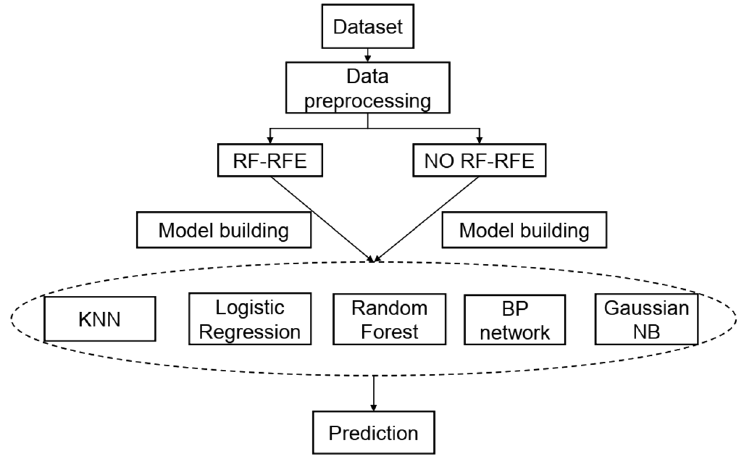
Figure 4. Research